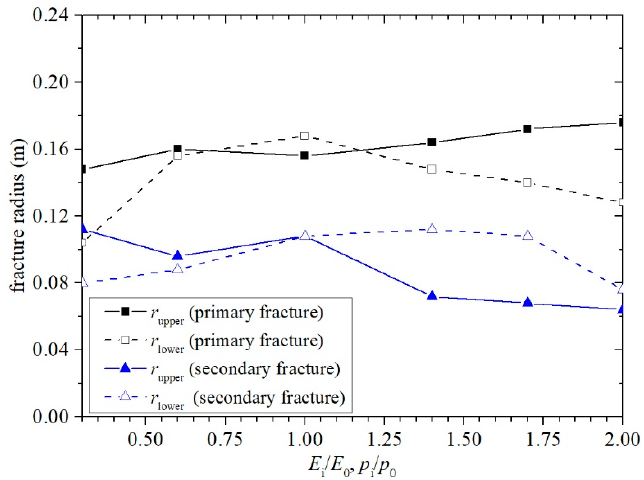
Figure 6. The minimum compressive principal effective stress (MPa) of models with different interlayer Young’s modulus and strength at t = 2000 s: ( a ) Multi-E1, E 1 / E 0 = 0.3; ( b ) Multi-E2, E 2 / E 0 =